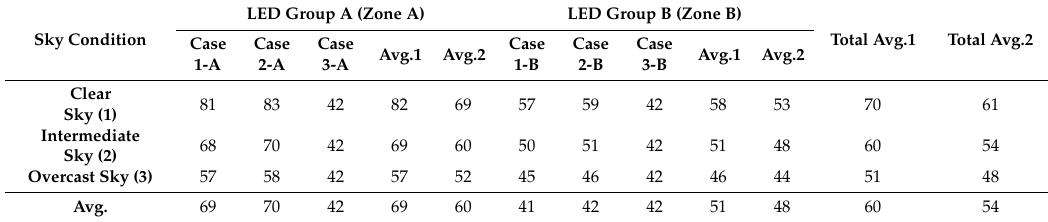
Table 8. Dimming rate for sky conditions with no blind (Avg.1: Case 1-A–2-A, Avg.2: Case 1-A–3- A).